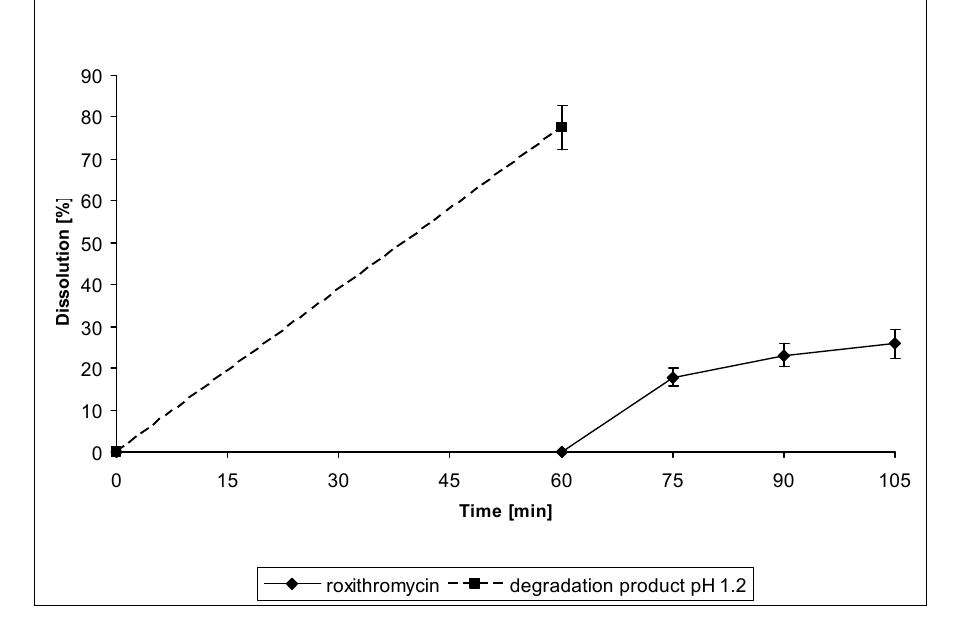
Figure 4. Dissolution of roxithromycin and its degradation product from tablets for oral suspension at pH 1.2-6.8 (acid stage-buffer